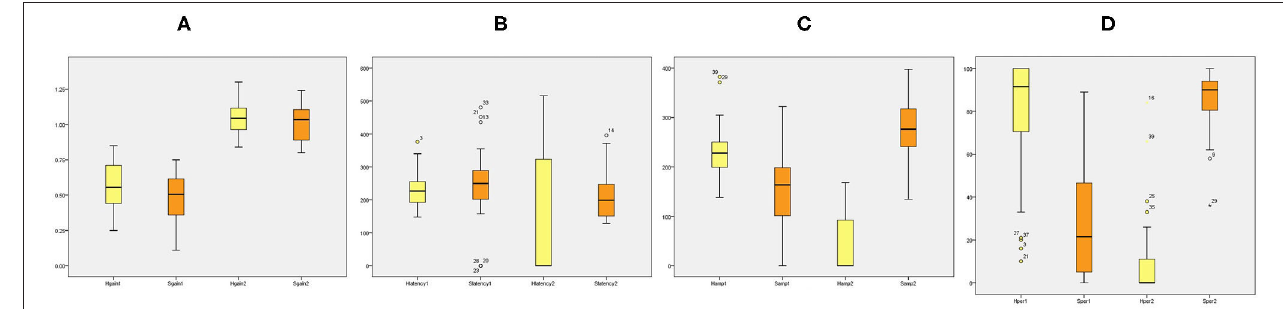
FIGURE 3 | Box plot for comparison of parameters between VN patients and healthy participants. (A) HIMP and SHIMP gain of VN patients and healthy participants. (B) HIMP and SHIMP saccade latency of VN patients and healthy participants. (C) HIMP and SHIMP saccade amplitude of VN patients and healthy participants.